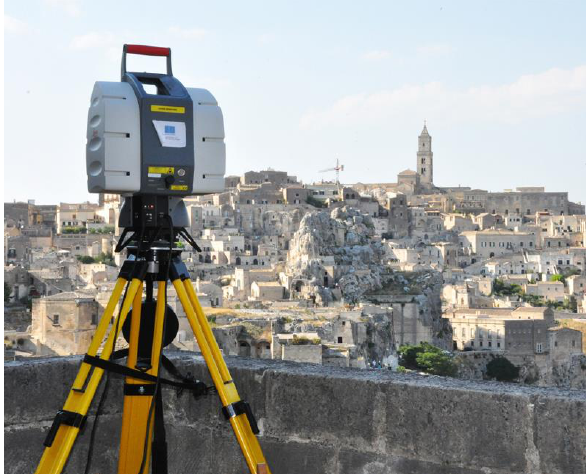
Figure 5. Laser scanner used for